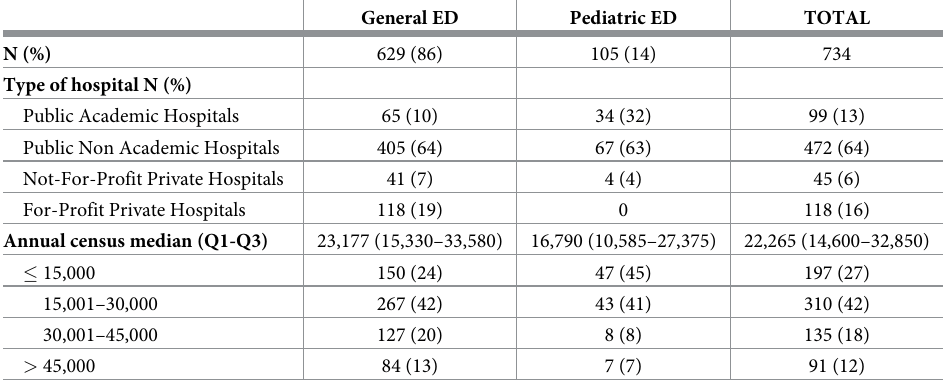
Table 1. Characteristics of all emergency